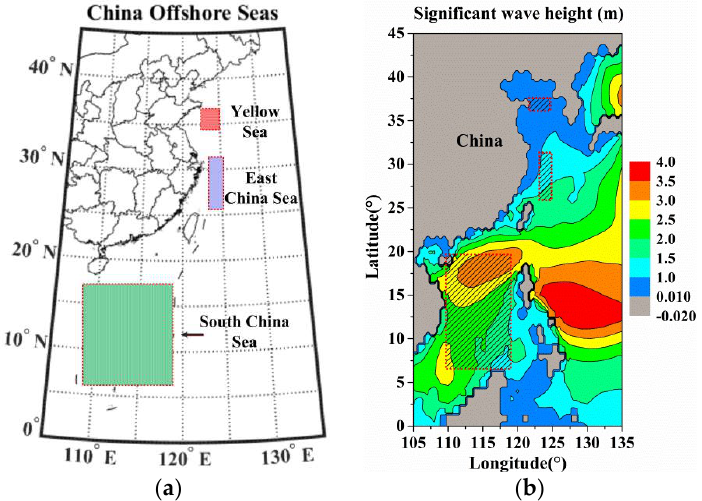
Figure 1. Study region of the China Offshore Seas and the sampling sea areas are marked by the dotted boxes: ( a ) The Latitude and longitude range of China Offshore Seas; ( b ) The two-dimensional (2D) color image of significant wave height data at 12:00 UTC on 1 February 2016. We can also regard the image as a 181 × 121 matrix, and the detailed data of interest are shown in Table 1.